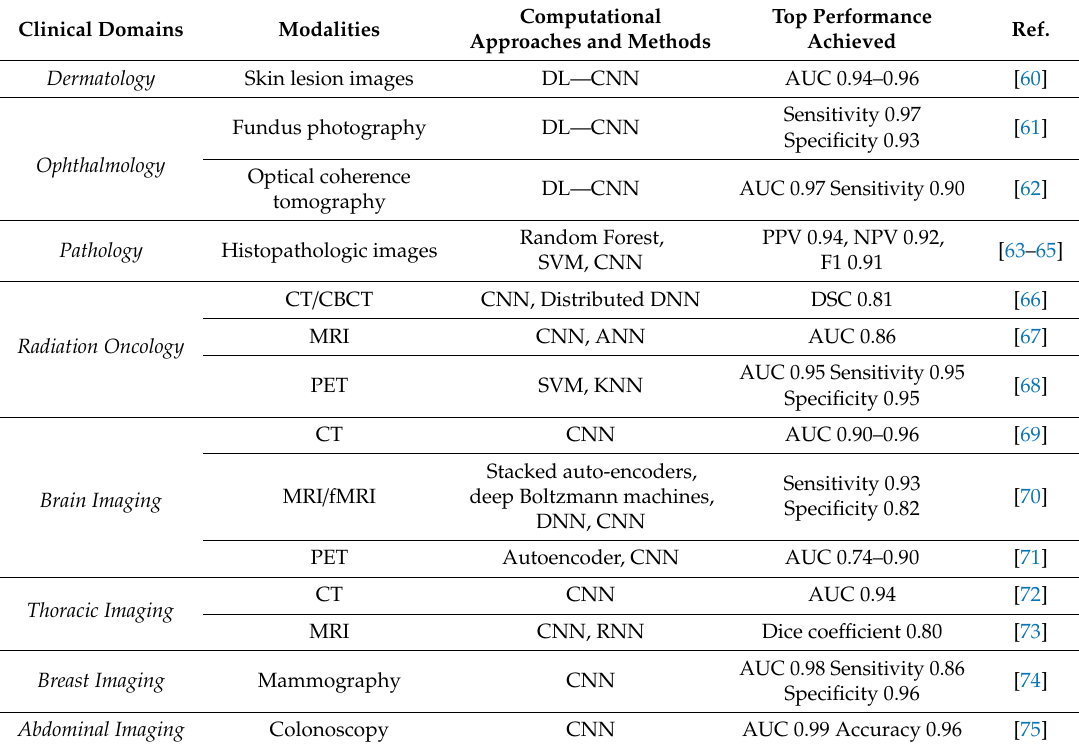
Table 1. Applications in clinical domains: significance for medical imaging and